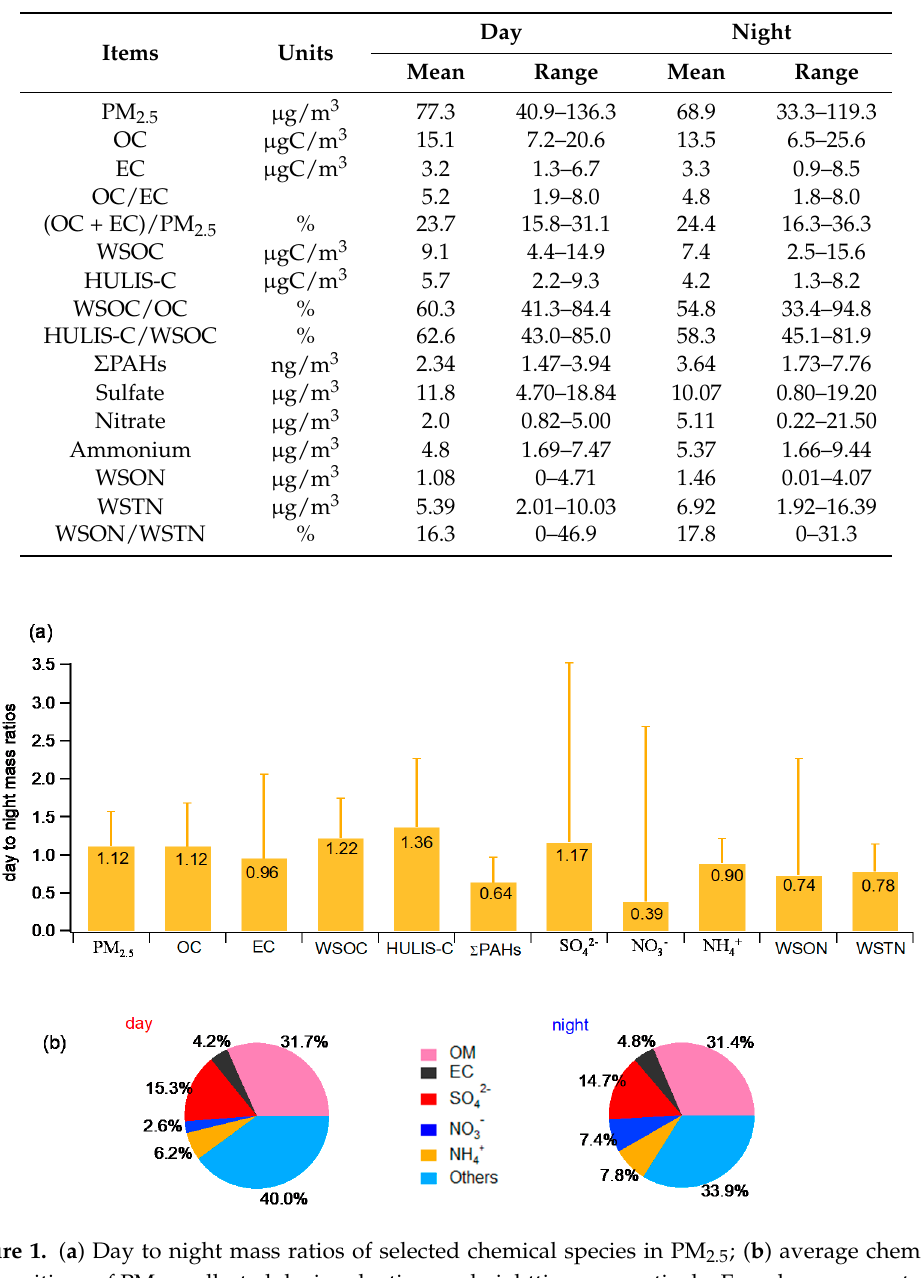
Table 1. The average mass concentrations and ranges of PM 2.5 , organic carbon (OC), elemental carbon (EC), water-soluble organic carbon (WSOC), HULIS-C, water-soluble total nitrogen (WSTN)/water-soluble organic nitrogen (WSON), and total polycyclic aromatic hydrocarbons ( Σ PAHs), etc. Data for daytime and nighttime samples are presented separately.